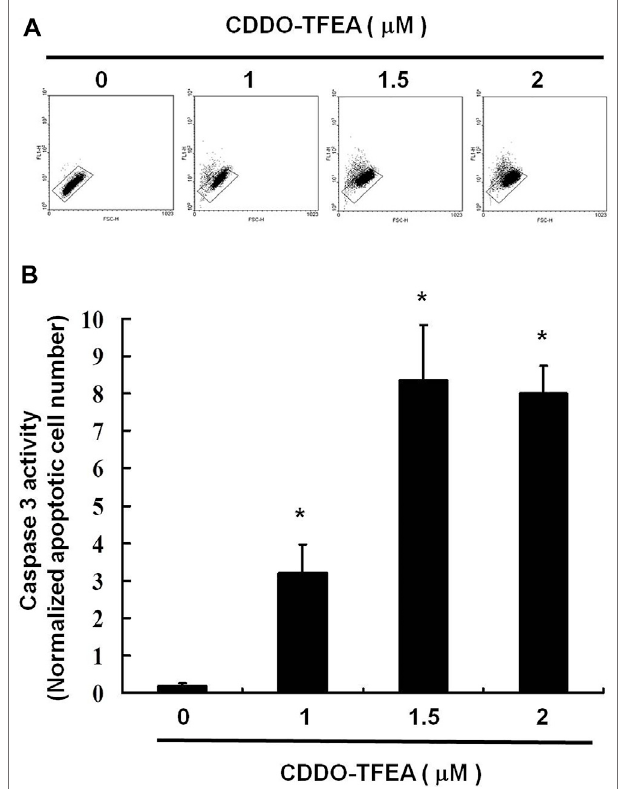
FIGURE 4 | (A) Numbers of active caspase-3 induced by CDDO-TFEA treatment on the GBM8401 cell line. (B) Results are expressed as a percentage of the control, with the control being 100%. All data are reported asthemeans and standarderrors ofthemeanonthebasisoftheresults of at least three separate experiments. Statistical analysis was performed using the t test, with differences between the treatment and control groups considered signi fi cant at p < 0.05, as denoted by *.